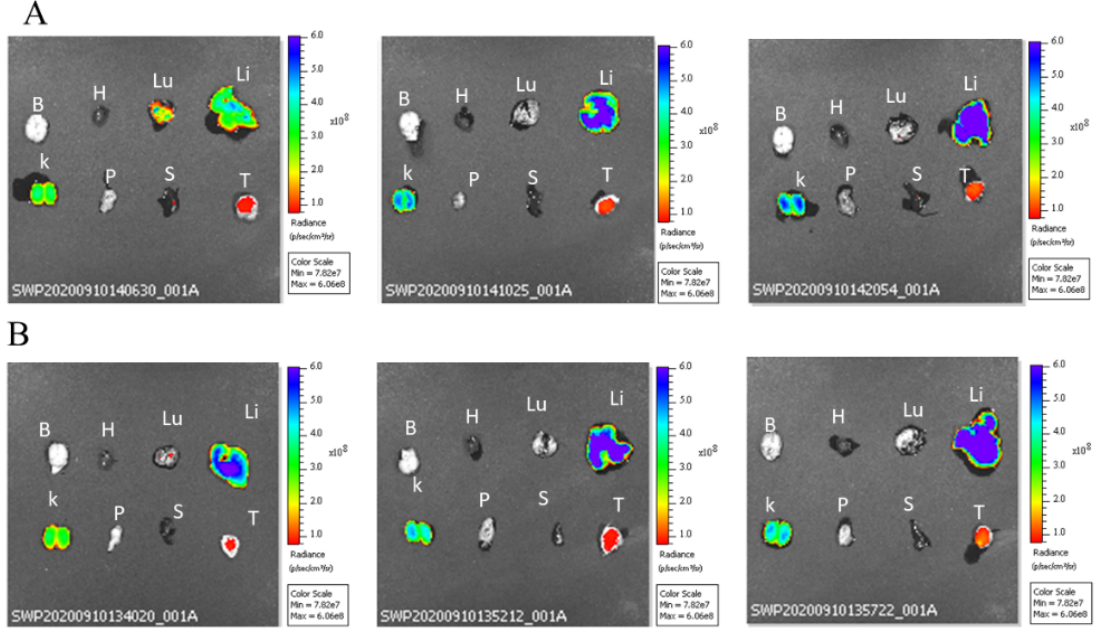
Figure 8. Ex vivo fluorescence image of selected major organs for ( A ) NP-cypate and ( B ) TF-NP-cypate (at cypate dosage: 1 mg/kg of mice). Note: brain (B), heart (H), lung (Lu), liver (Li), kidney (K), pancreas (P), spleen (S), and tumor (T).